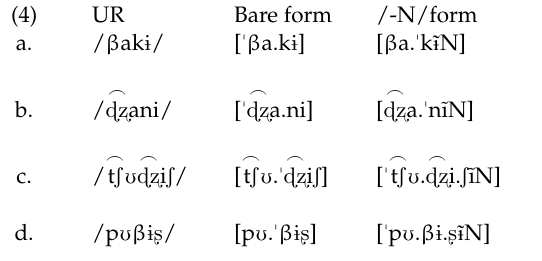
segments that lack a specification for PoA in the oral cavity: a nasalized glottal stop; and a nasalized glottal continuant, which, based on McCawley (1968), is reported to be usually phonetically realized as a nasal continuation of the preceding vowel or as a velar or uvular nasal. The latter is quite close to the behavior for /N/ observed in Shipibo-Konibo/Capa- nahua. In this study, I will continue to use the [N] symbol to denote the output corre- spondent of the placeless nasal /N/ in word-final position, independently of how it is pho- netically realized. In terms of phonological features, I assume /N/ is minimally specified as [+consonantal, +sonorant] and [+nasal]. Crucially, it lacks the [–continuant] feature pre- sent in other nasals, and a specification for PoA within the oral cavity. The occurrence of [N] on the surface is restricted to appear in coda position in both Panoan languages and it is in complementary distribution with /m/ and /n/, which are only found in the onset position of syllables (Section 5 describes what happens when /N/ is followed by a vowel and, therefore, resyllabified as an onset). A conspicuous character- istic of [N]-coda is that it completely nasalizes all vowels and glides around it. This phe- nomenon is responsible for the nasalized vowels observed in both languages: [ ã,